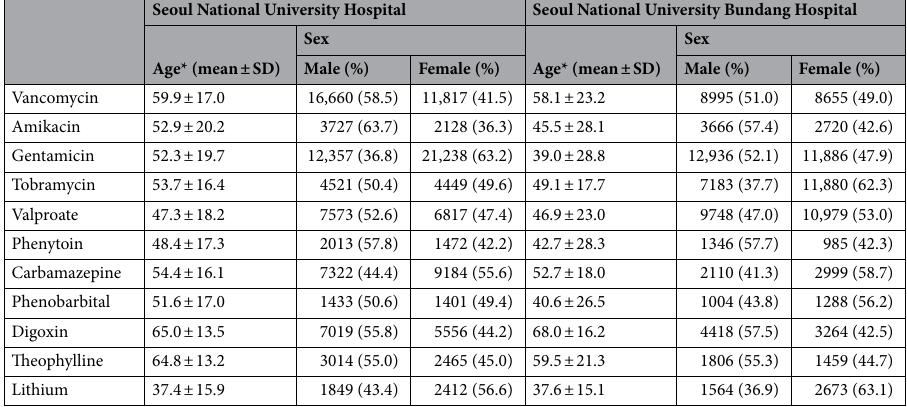
Table 1. Demographics of the patient population. *The age was calculated to average. The ratio was rounded to the first decimal place.